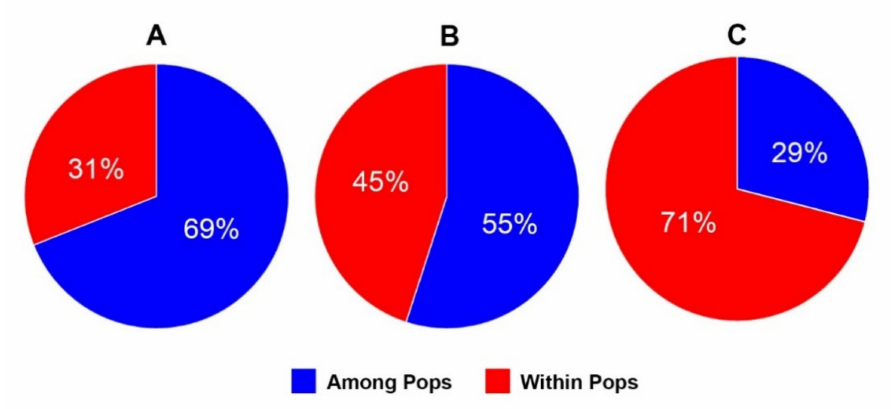
Figure 5. Contribution of genetic variation within and among populations for the examined populations by AMOVA, based on ISSR markers ( A = whole examined populations, B = native populations, C = invasive A. franciscana ).